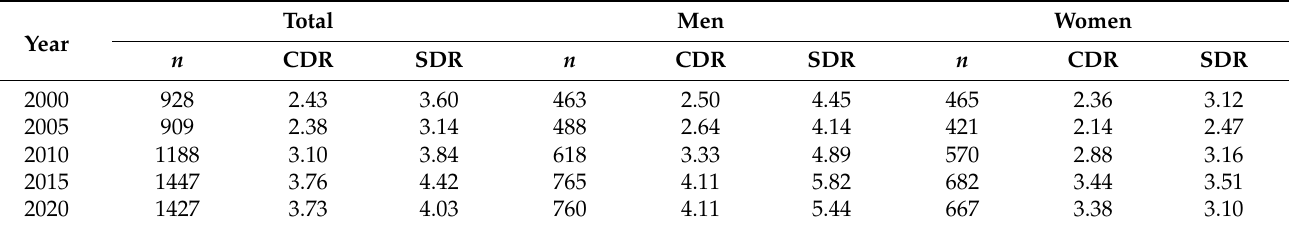
Table 3. Number of deaths, CDR per 100,000 and SDR per 100,000 due to skin melanoma of urban residents in Poland by gender in 2000, 2005, 2010, 2015 and 2020.